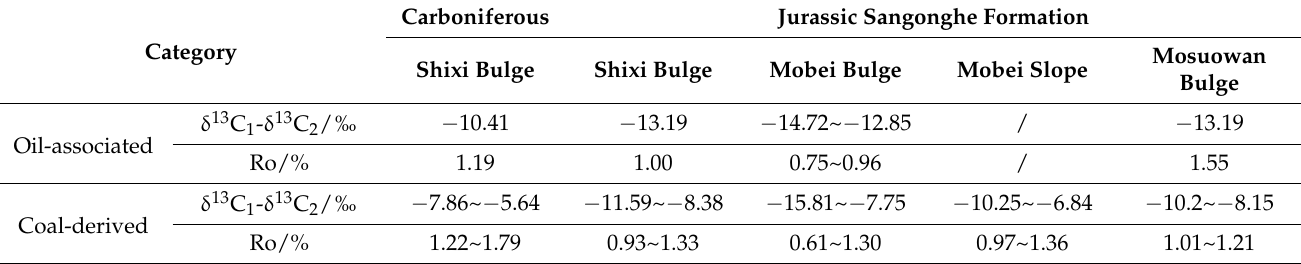
Table 4. Maturity degrees of natural gases in the eastern belt around the Penyijingxi sag, Jung- gar